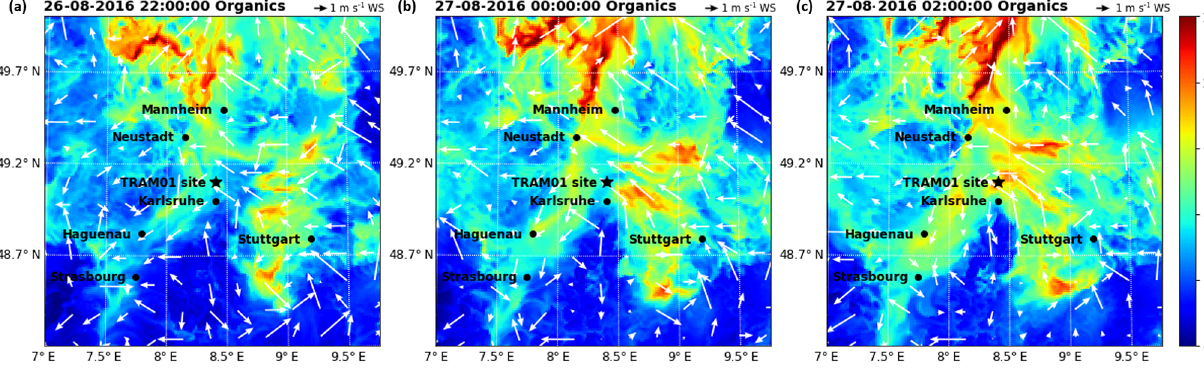
Figure 8. Particulate organic concentrations calculated by COSMO-ART for three different time points (a–c) during the night from 26 to 27 August for 10ma.g.l.